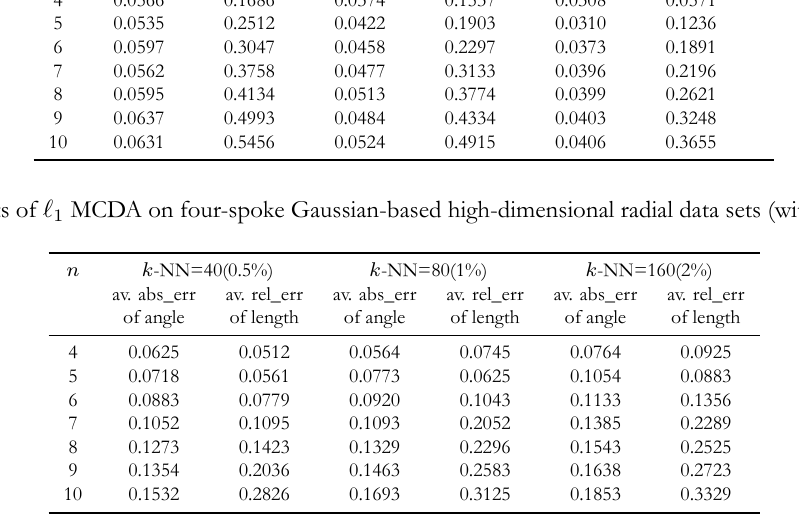
Table 8: Results of ℓ 1 MCDA on four-spoke Student t -based high-dimensional radial data sets (with 10% outliers) n k